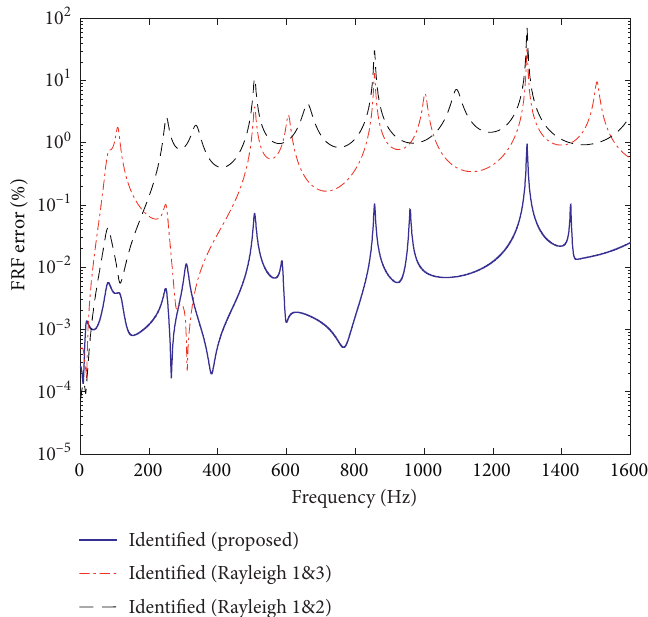
Figure 5: Relative error between the amplitudes of the reconstructed FRF and the accurate one for case 1.